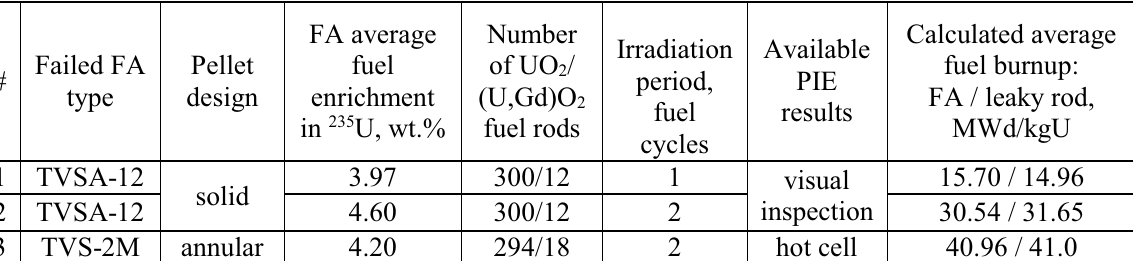
Table I: Parameters of the failed FAs that were used for model calculations in the analysed